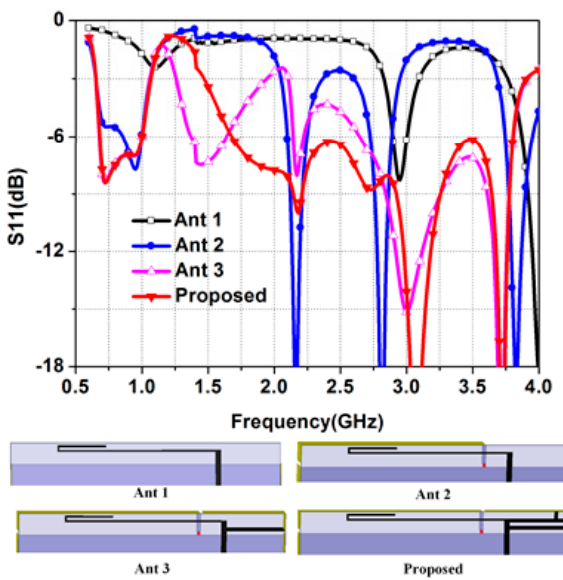
Figure 2. Simulated S-parameters of Ant 1, Ant 2, Ant 3, and the proposed antenna.